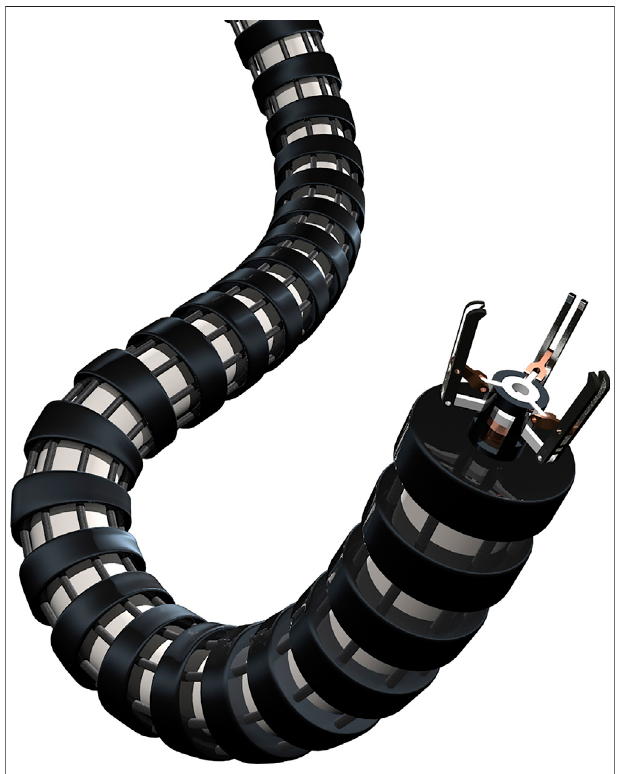
FIGURE 1 | Example rendering of a tendon-driven continuum robot.